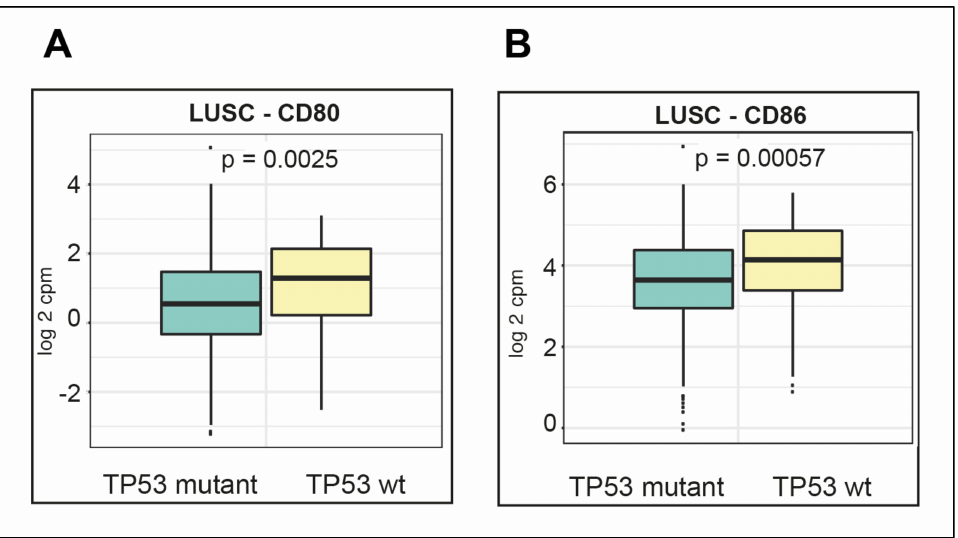
Figure 9. Expression of checkpoint Cytotoxic T-Lymphocyte Associated Protein 4 (CTLA-4) ligands: CD80 and CD86; di ff ers in LUSC according to TP53 status. Expression is plotted for ( A ) CD80 and ( B ) CD86, for LUSC with either wt TP53 or mutant TP53. Propensity scores were included and expression di ff erences assessed for significance ( p <